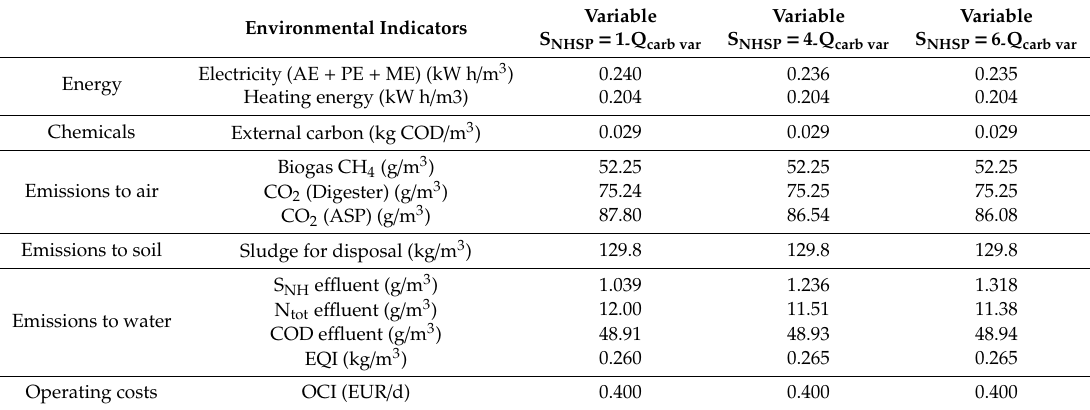
Table A1. Annual values of environmental indicators and operating costs of BSM2 plant with respect to the volume of treated wastewater with alternative